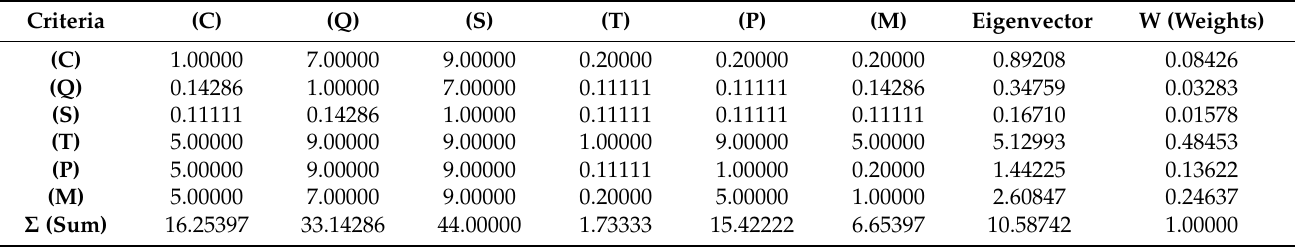
Table 9. Judgment matrix (full packaging engineer